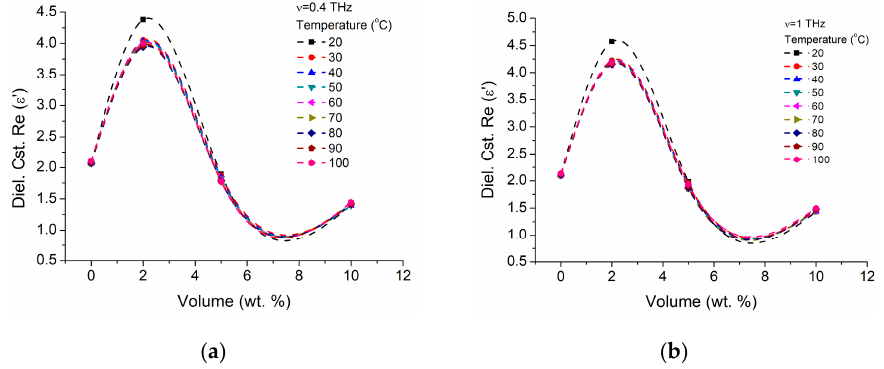
Figure 16. BTO-SBS dielectric constant real part ( ε′ ) variation on nanoparticle volume fraction, at different temperatures for ( a ) 400 GHz and ( b ) 1 THz.